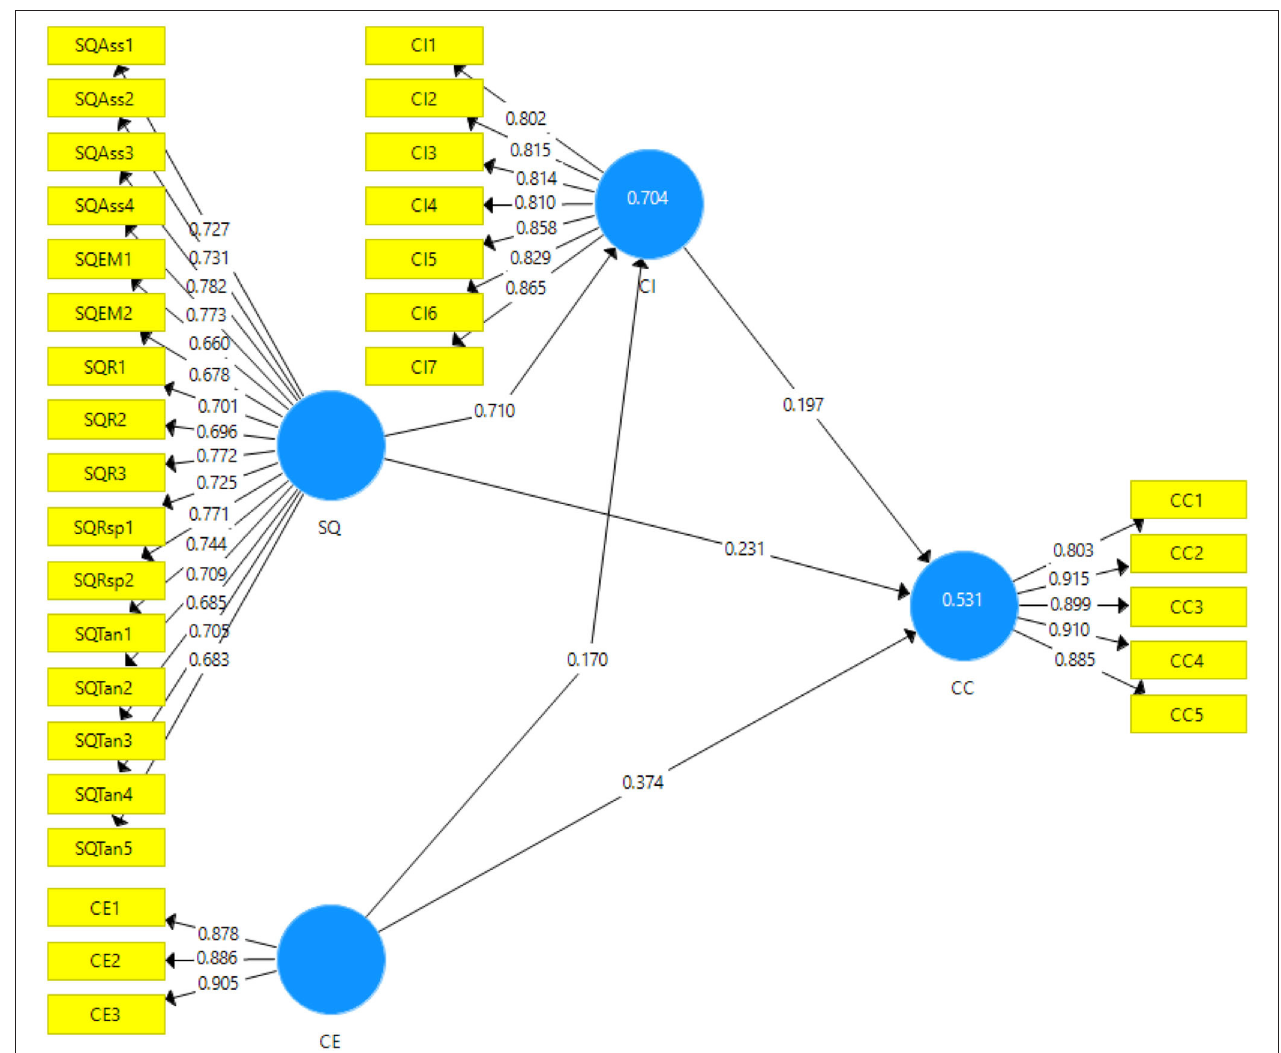
FIGURE 2 | Output of measurement model algorithm. SQ, Service quality; CE, Customer experience; CI, Corporate image; CC, Customer